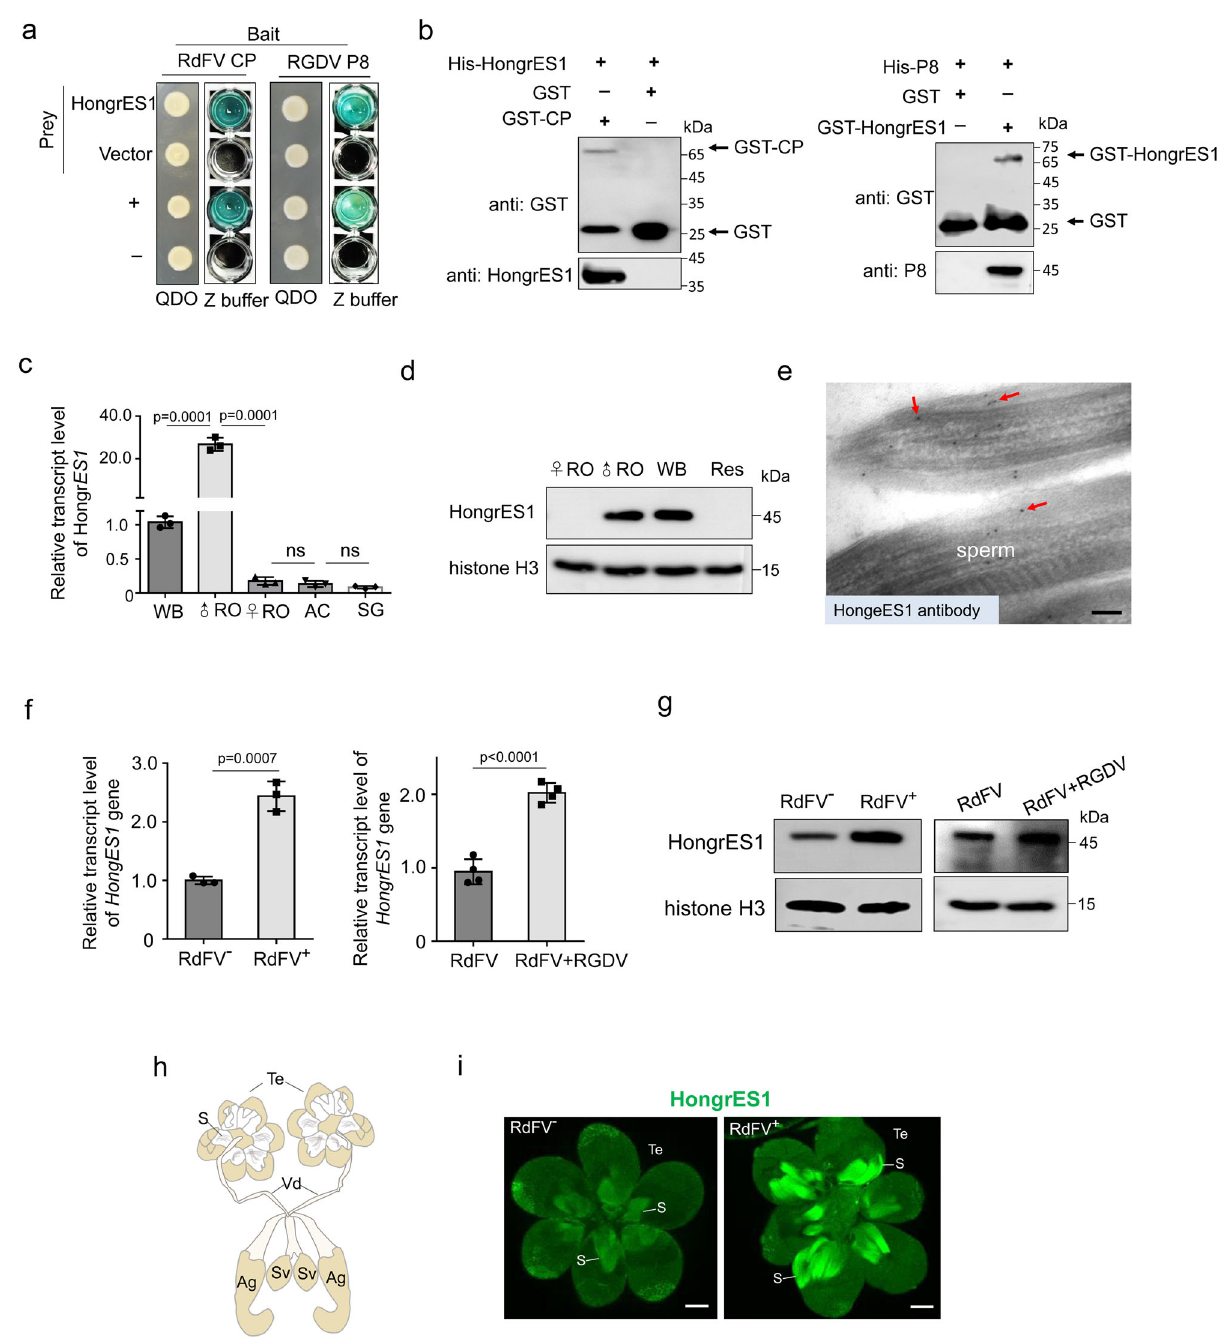
Fig. 2 | Sperm-speci fi c HongrES1 of R. dorsalis interacts with RdFV CP orRGDV P8. a Y2H assays showing interaction of HongrES1 with RdFV CP or RGDV P8. TransformantsonQDOplatesarelabeledasfollows:HongrES1,pPR3-N-HongrES1/ pDHB1-CP or -P8; vector, pPR3-N / pDHB1-CP or -P8;+, positive control, i.e., pLar- geT/p53; – , negative control, i.e., pDHB1 / pRR3N. β -galactosidase assay was detected in Z buffer with X-Gal. QDO, SD/-Trp-Leu-His-Ade medium. b GST pull- down assays showing interaction of HongrES1 with RdFV CP or RGDV P8. c , d HongrES1 expression levels in different organs of 30 RdFV-positive leafhop- pers, as determined by RT-qPCR ( c ) and western blot ( d ) assays, respectively. Means (± SD) are shown from three biological replicates (two-tailed t-test). Ns, not signi fi cant. WB, whole bodies. ♂ RO, male reproductive organs. ♀ RO, female reproductive organs. AC, alimentary canals. SG, salivary glands. Res, residues. e Localization of HongrES1 on sperm surface in male testis, as determined by immunoelectron microscopy. Testes of leafhoppers were immunolabeled with